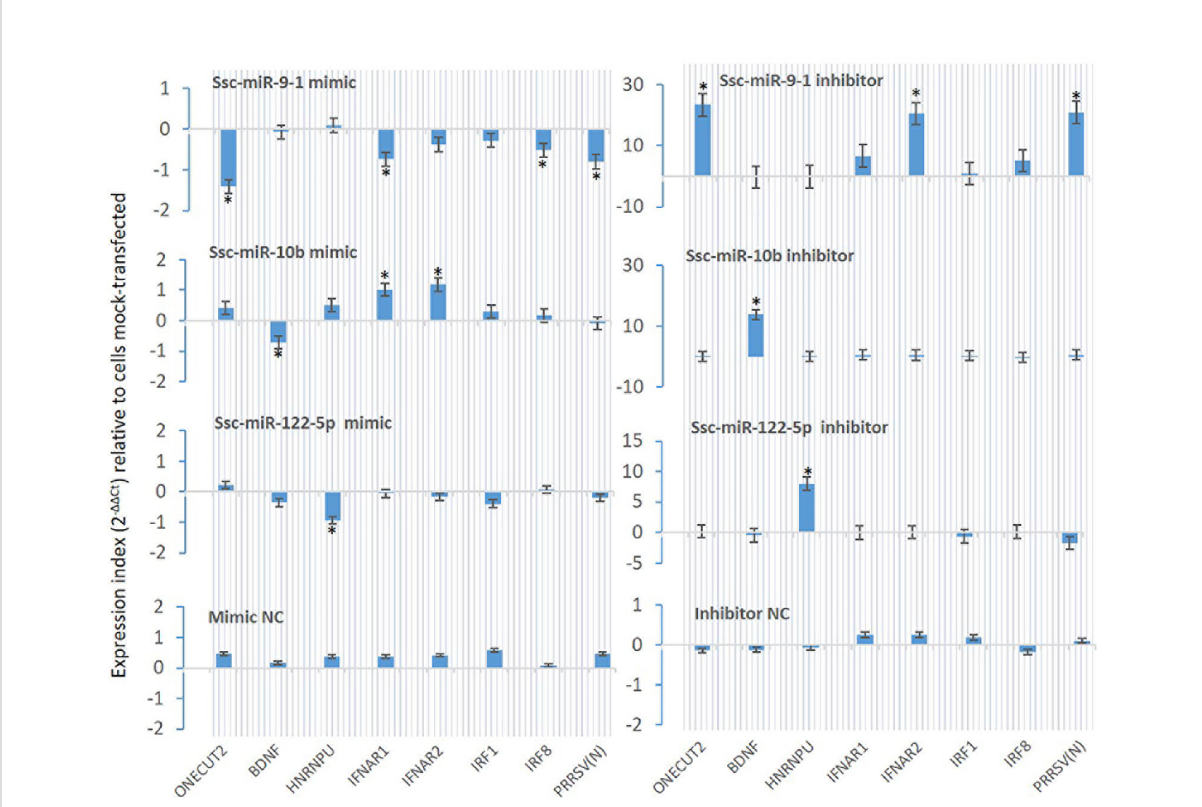
FIGURE 8 Validation using synthetic siRNA mimics with identical sequences or inhibitors antisense to selected miRNAs. Synthesis of siRNA mimics/ inhibitors and transfection of porcine macrophages were performed as described, and gene speci fi c RT-PCR was used to quantify the expression of target genes as labeled under the X-axis. The Gene abbreviation and GenBank Accession numbers of the tested transcripts are listed in Supplemental Excel Sheets. *p < 0.05, n = 3 relative to cells